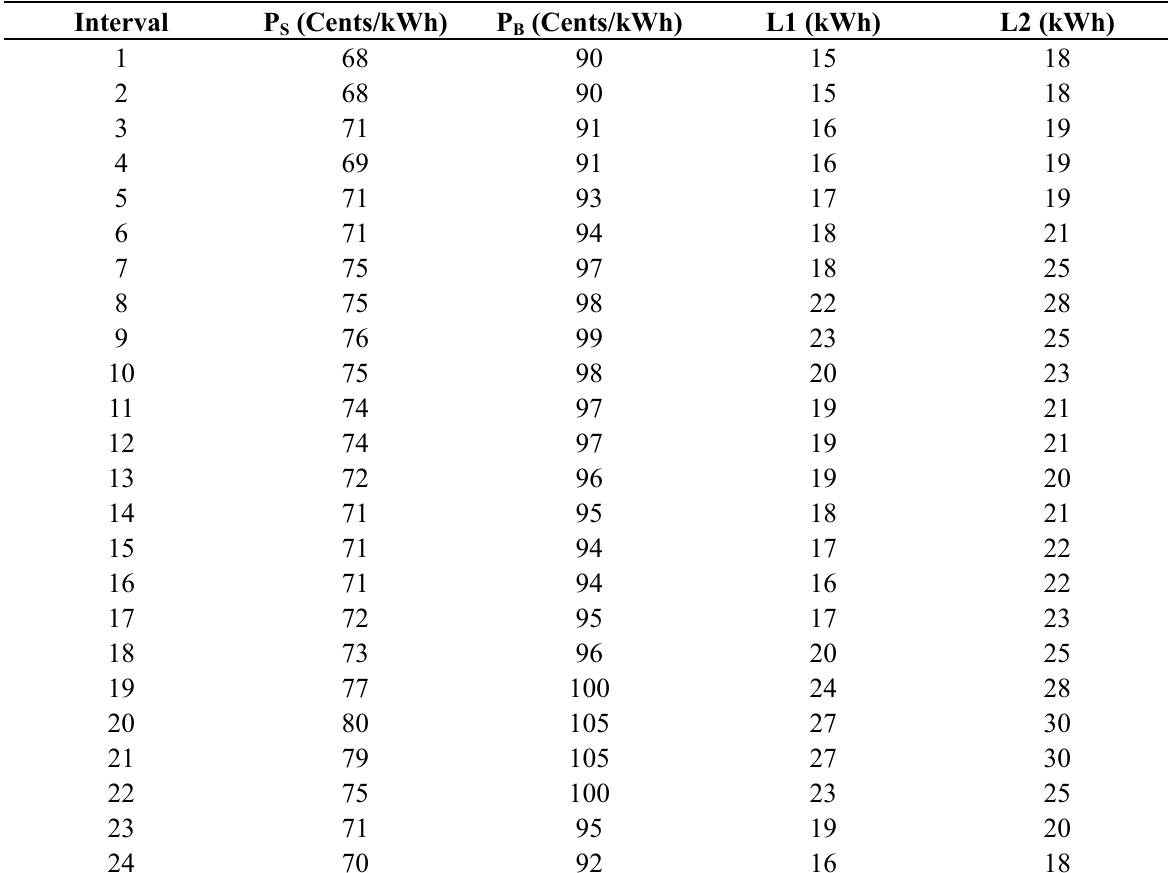
Table 2. Power trade prices with the power grid and loads in 24 intervals.